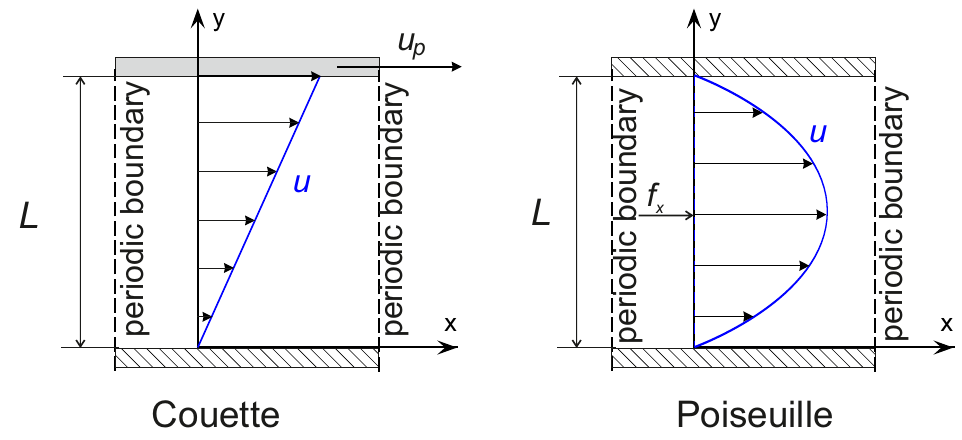
Figure 15. Couette and Poiseuille Flows: Schematic representation of the